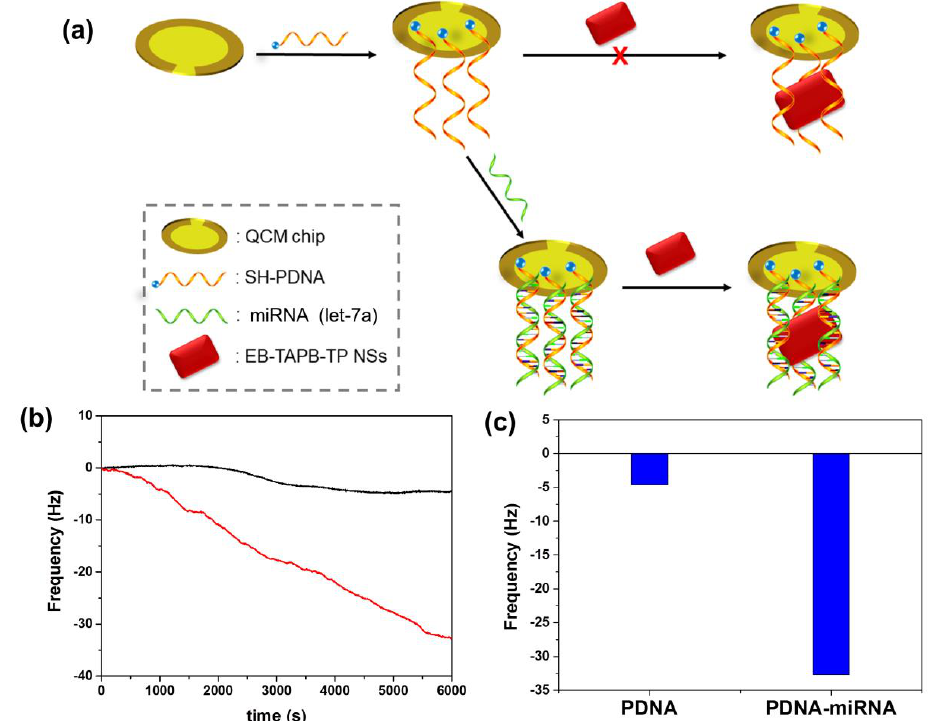
Figure 5. ( a ) Schematic outline of the QCM sensing system. ( b ) Real-time frequency responses of EB − TAPB − TFP NSs on the QCM sensor incubated with different concentrations of miRNA (let − 7a). From up to down at 6000 s: 0 nM and 50 nM. ( c ) Frequency changes of EB − TAPB − TFP NSs on the QCM sensor incubated with PDNA and PDNA − miRNA heteroduplex.